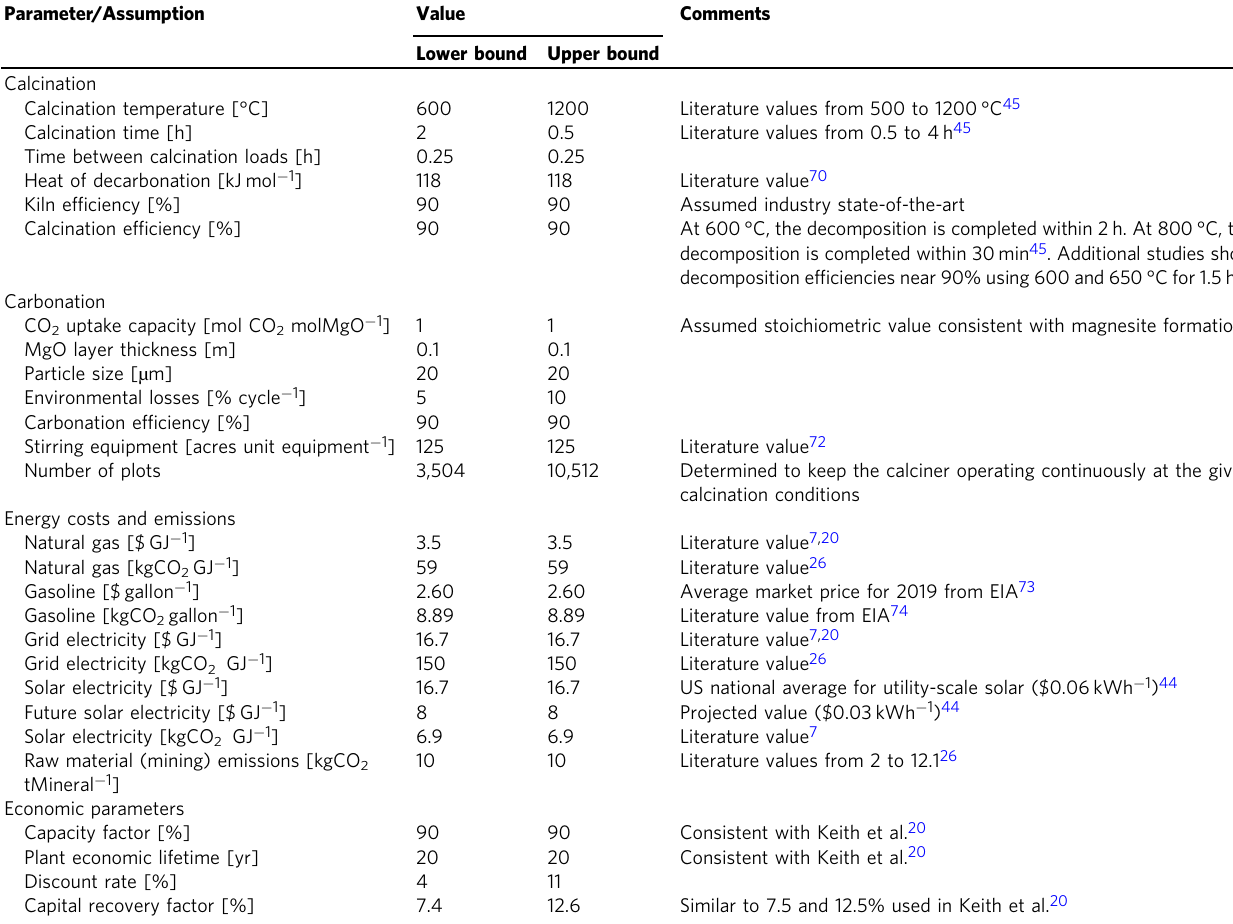
Table 1 Assumptions and parameters used for the upper and lower bounds in the process model.